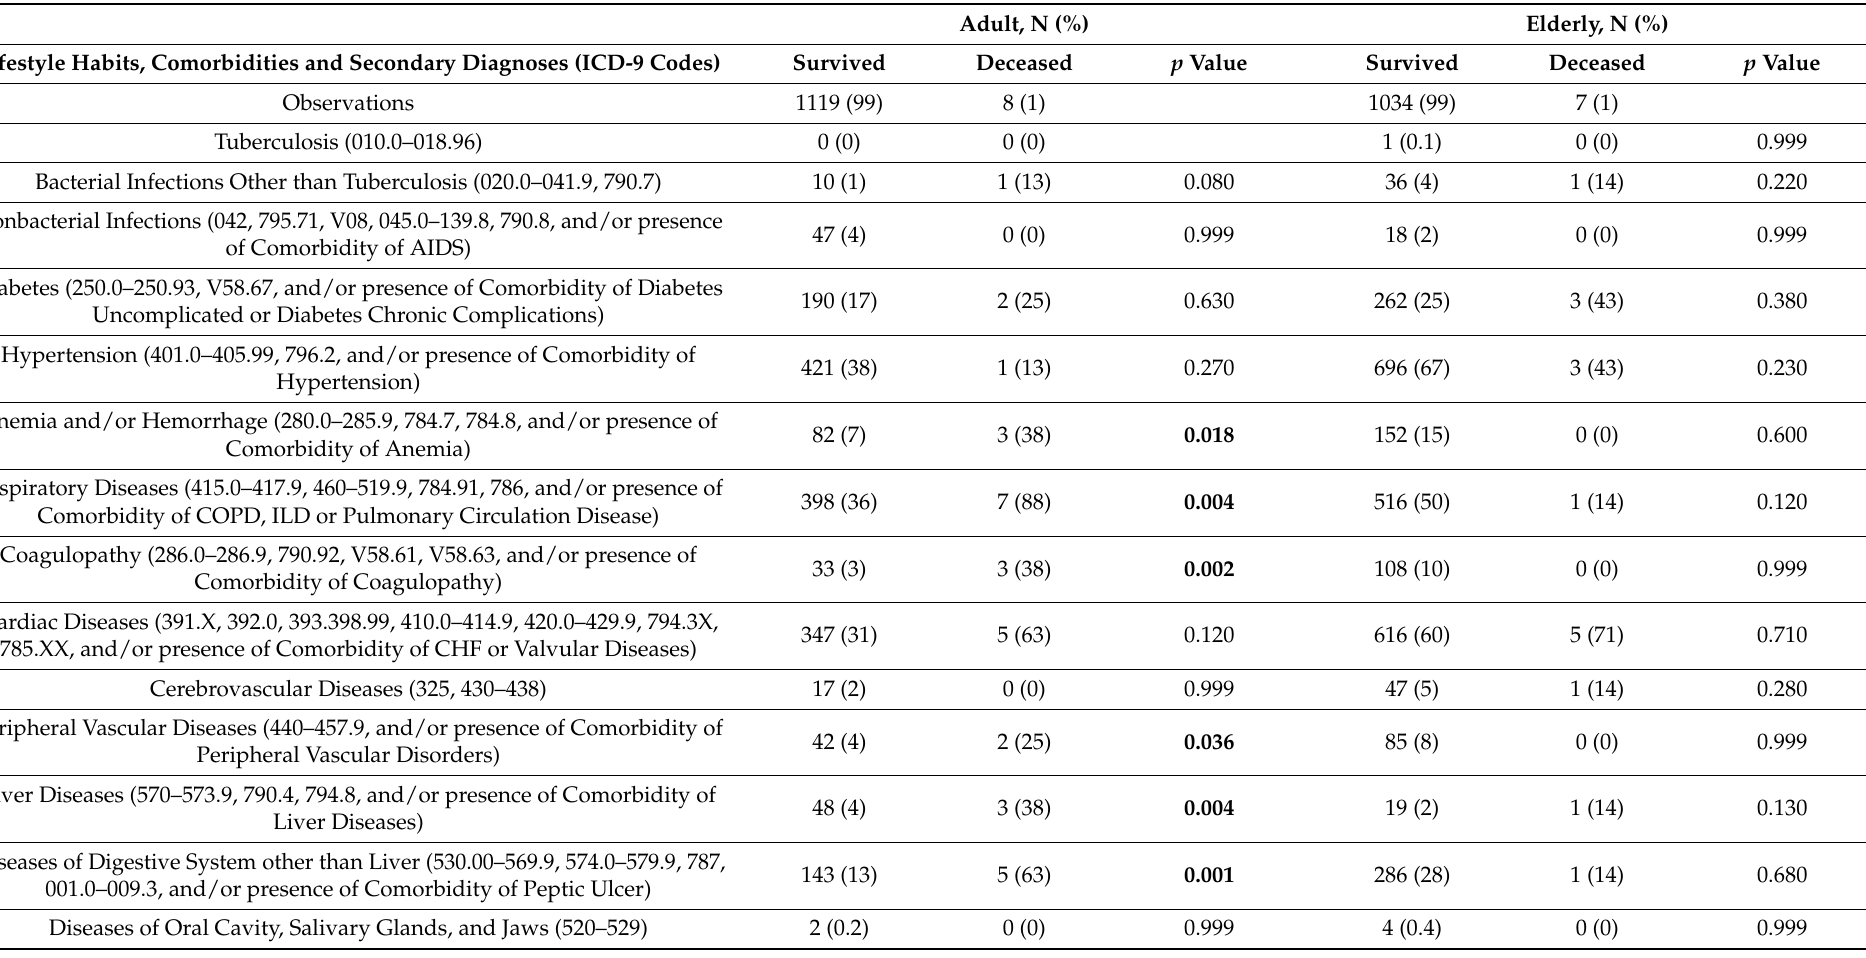
Table 5. Secondary diagnoses of patients emergently admitted with a primary diagnosis of blunt chest wall injury (NIS 2004–2014). Data are stratified according to survival status. Adult, N (%) Elderly, N